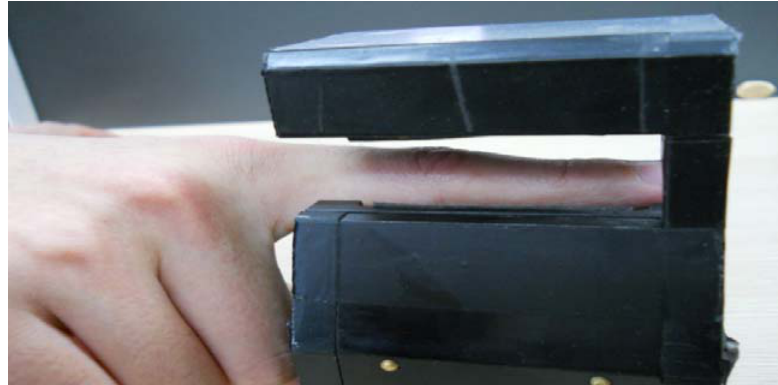
Figure 5. The data capture device.